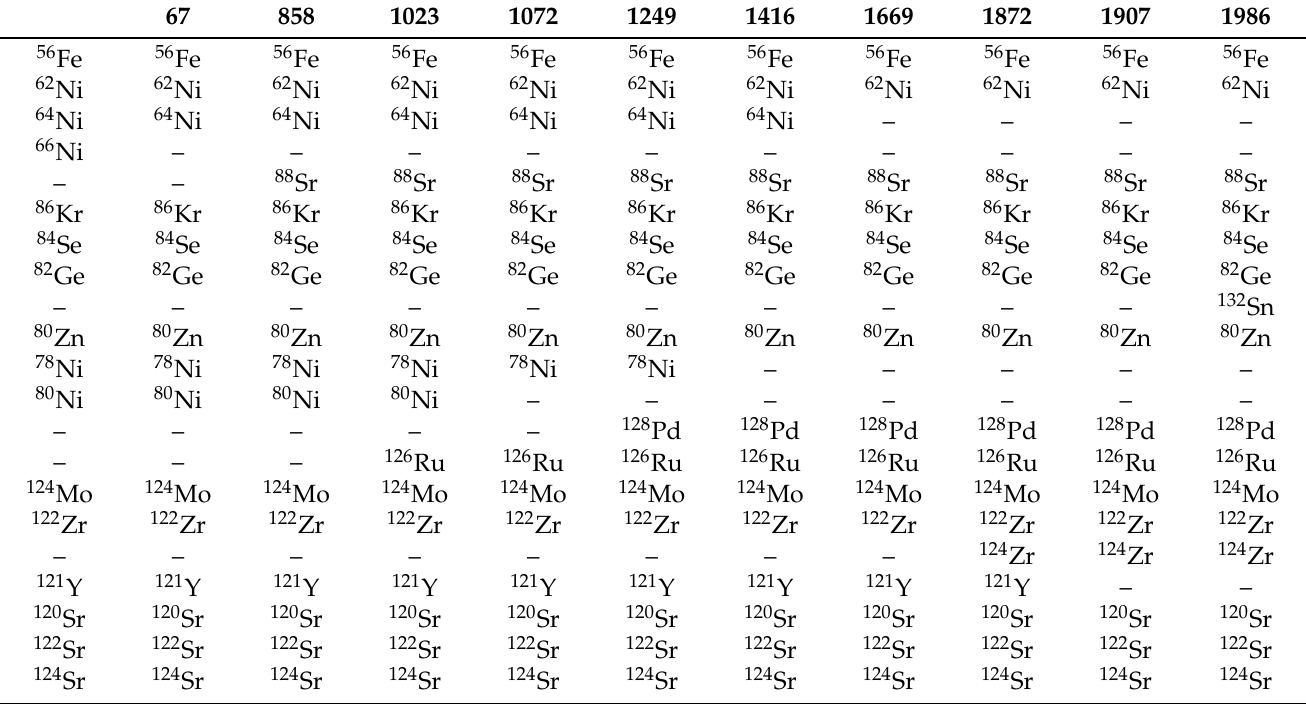
Table 2. Sequence of equilibrium nuclides with increasing depth (from top to bottom) in the outer crust of a magnetar for different magnetic field strengths. The first row indicates values of B (cid:63) = B / B rel associated with a change of composition. Results are valid up to B (cid:63) = 2087.